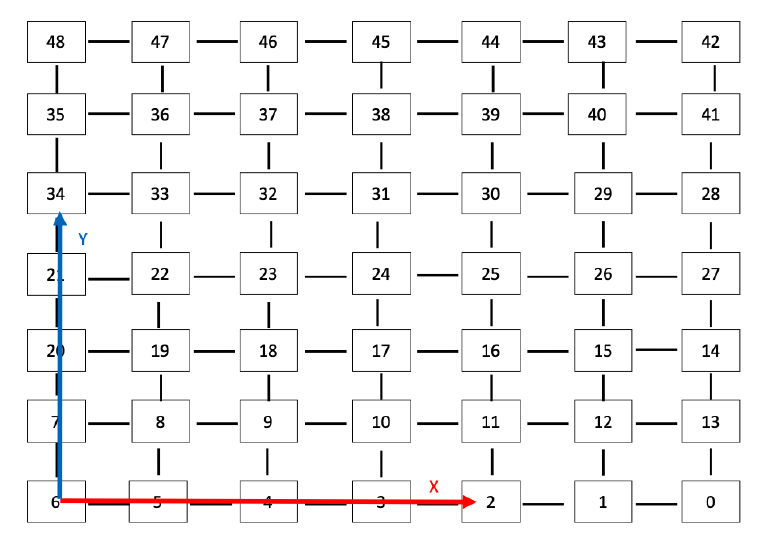
Figure 5. Markers in the towing tank.